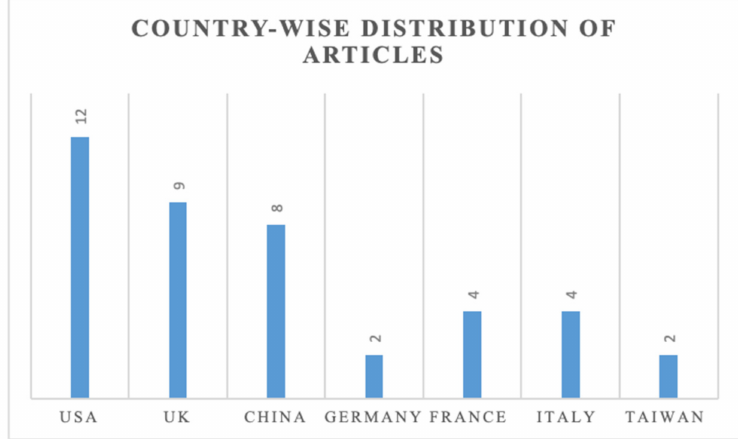
Figure 3. Country-wise distribution of